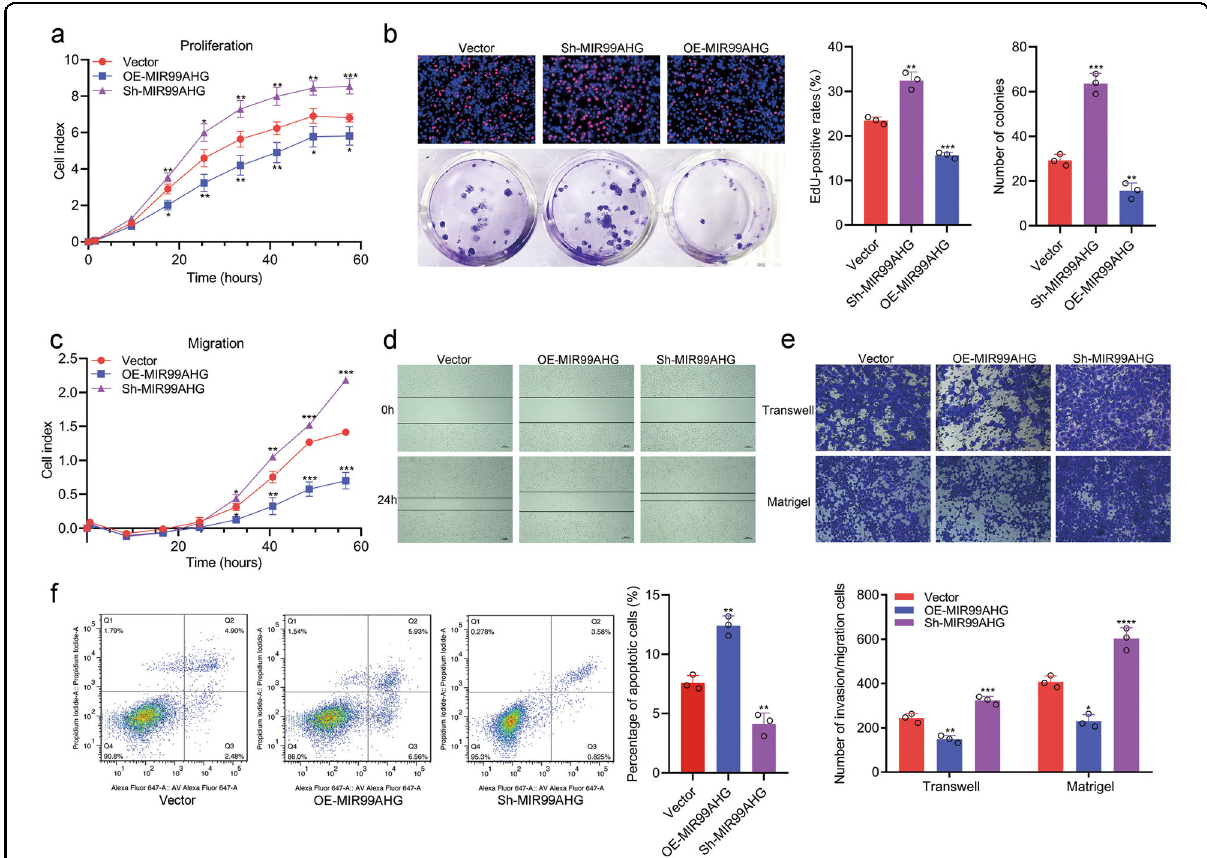
Fig. 3 MIR99AHG suppresses proliferation, migration, and invasion of H1299 cells in vitro. a and b MIR99AHG inhibited the proliferation abilities of H1299 cells, as shown by RTCA proliferation assays ( a ), EdU assays ( b , upper panel), and colony formation assays ( b , lower panel). c – e MIR99AHG inhibited the migration and invasion abilities of H1299 cells, as shown by RTCA migration assays ( c ), wound-healing assays ( d ), and transwell and Matrigel assays ( e ). f Cell apoptosis analyses of H1299 cells transfected as indicated. Cells were harvested for Annexin-V/d PI double staining followed by fl ow cytometry analysis. All experiments were repeated three times with similar results and images are representative of three independent experiments. A two-tailed Student ’ s t -test was used for statistical analysis. * P < 0.05, ** P < 0.01, *** P < 0.001. Error bars,